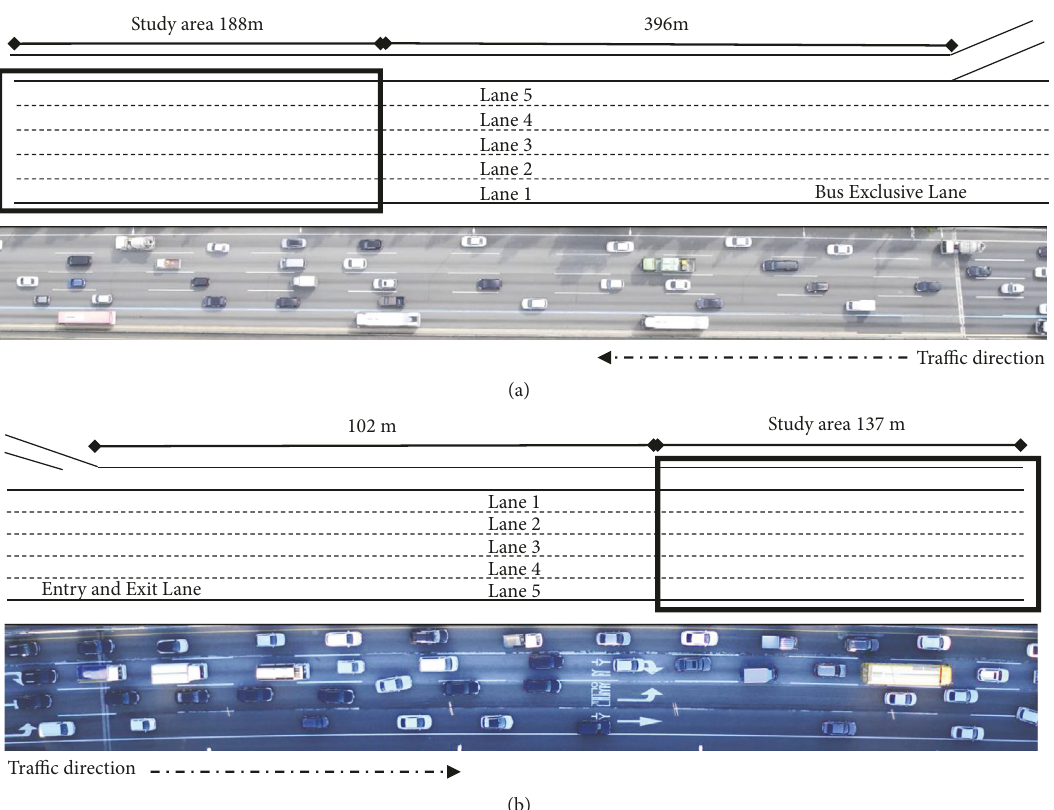
Figure 4: Images of the studied congested freeway from the UAV: (a) Korea Expressway No. 1 with cloudy after sunrise and (b) Korea Expressway No. 120 with clear before sunrise.